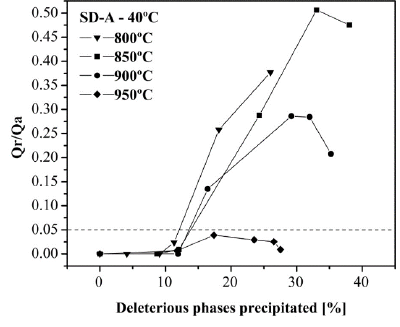
Figure 7. Q /Q versus deleterious phases for SD-A in 2.00 M H r a + 0.01 M KSCN + 0.50 M NaCl solution test at 40 °C.